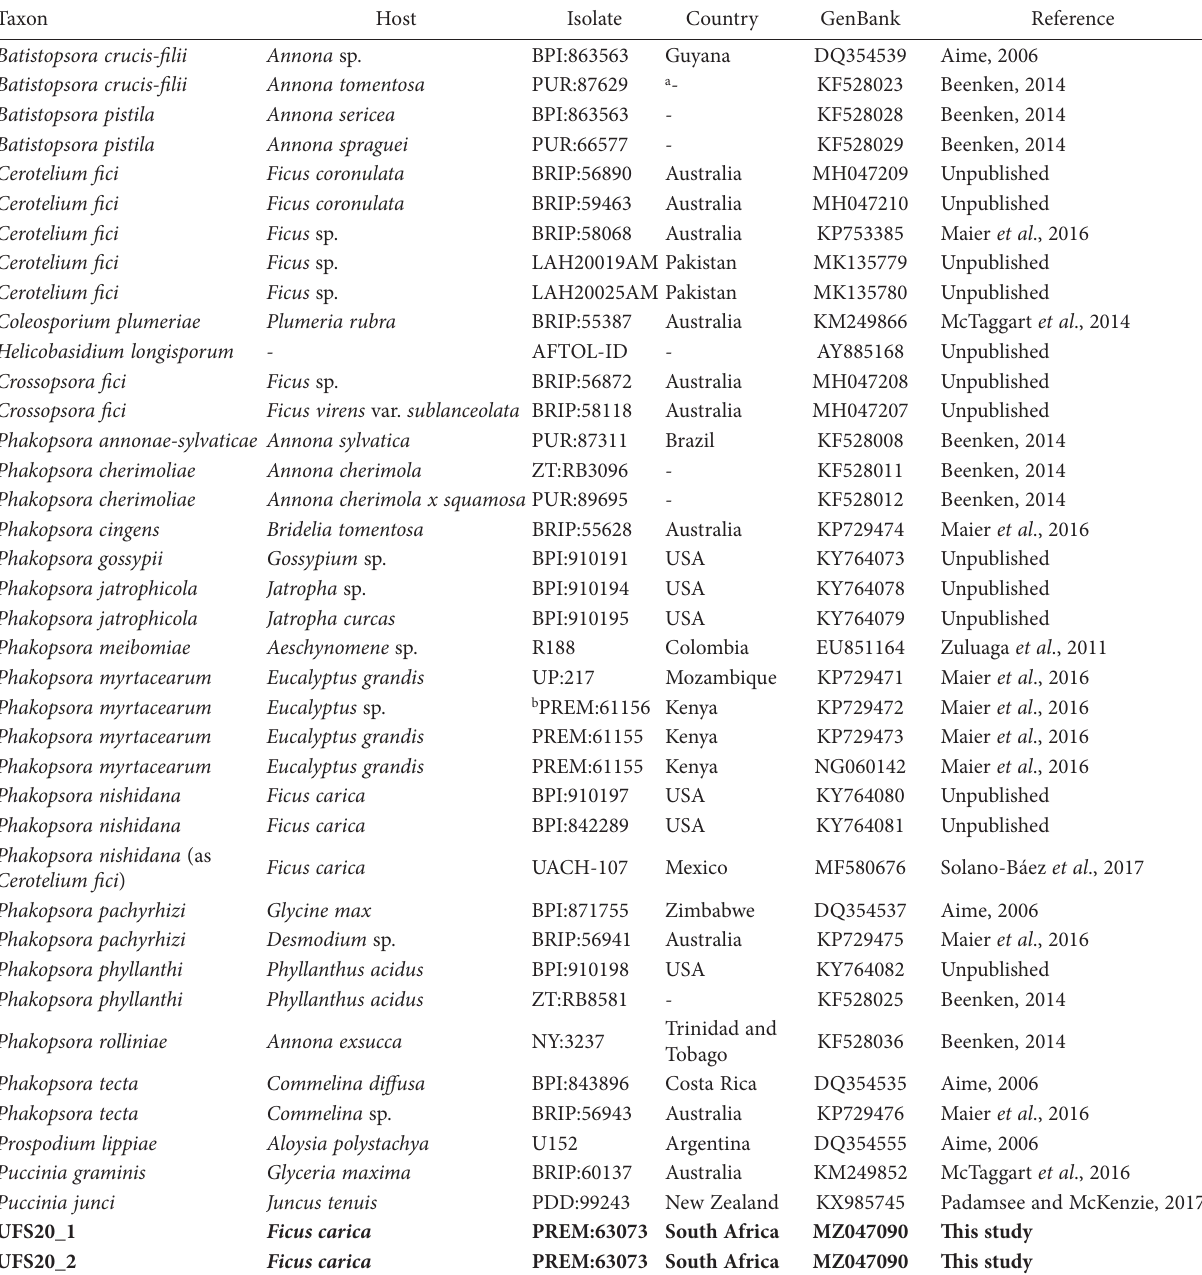
Table 1. Taxa used in the molecular identification of the Vermont fig rust isolate PREM63073. Allelic variants of the isolate identified in the present study are indicated in bold